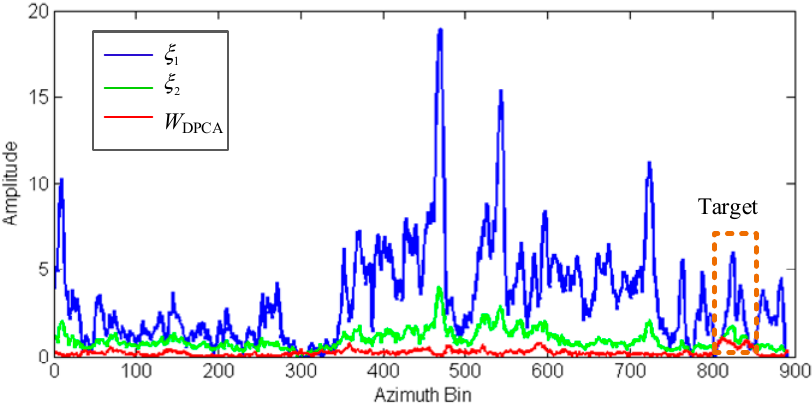
Figure 8. The amplitude curves of SAR images manipulated with ξ 1 , ξ 2 , and W DPCA